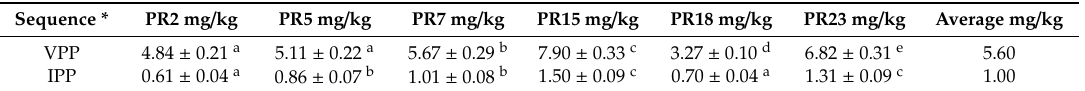
Table 3. Amount of VPP and IPP in the peptide fractions of Parmigiano Reggiano (PR) samples at 12 months of ripening belonging to the group LL (low-fat and low-salt). Sequence * PR2 mg /